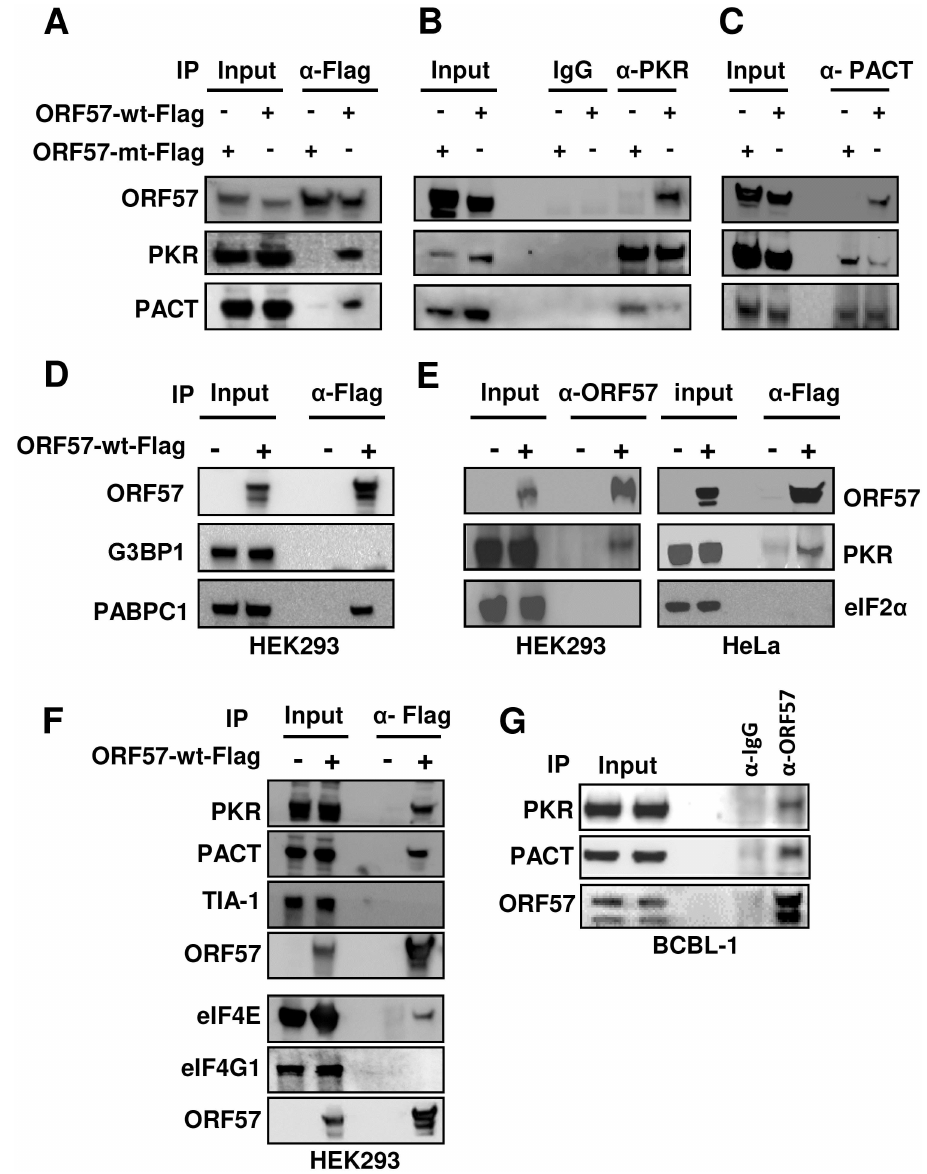
Fig 5. ORF57 interacts with PKR, PACT and PABPC1, but not G3BP1, eIF2 α and TIA-1. (A-C) ORF57, but not ORF57 mt, interacts with componentsPACT and PKR of SG and inhibitstheir recruitmentactivities in arsenite-treated cells. HEK293cells were transfected with an empty vector (-) or a vector expressingFlag- taggedORF57-wt or ORF57-mt. Total cell lysates at 24 h after transfectionwere digested with RNase A/T1 to excludeany possibilityof RNA-mediatedprotein-protein interactions in subsequent co-immunoprecipitation. (A) The ORF57-associatedproteins were co-immunoprecipitated by a mouse anti-Flag antibody for ORF57 and the proteins in the pulldownwere blotted with each correspondingantibody for endogenousPKR and PACT in additionto ORF57. (B-C) ORF57 interactionwith PACT and PKR inhibitsarsenite-induced PACT-PKR interactions. RNase-treated cell extracts in (A) were immunoprecipitatedby an anti-PKR(B) or anti-PACT (C) antibody,and blotted for PKR-associated ORF57 and PACT (B) or PACT-associated ORF57 and PKR (C). Anti-Flag antibodywas used to blot wt and mt ORF57. (D-F) Interaction of ORF57 with PABPC1, PKR, PACT and eIF4E, but not with G3BP1, eIF2 α , TIA-1 and eIF4G1. The cell extract derived from HEK293 or HeLa cells with transfectionof an empty vector or an ORF57-wt-Flag expressionvector were treated with RNase A/T1 and then co-immunoprecipitated by a mouse anti-Flag for ORF57 (D-F) or a polyclonal rabbit anti-ORF57 (E, left panel)for ORF57-associatedG3BP1 and PABPC1 (D), PKR and eIF2 α (E), and PKR, PACT, TIA-1, eIF4E and eIF4G1 (F). Approximate 30% proteins pulleddown from the co-IP were blotted with the corresponding antibody for G3BP1, PABPC1, PKR, eIF2 α , PACT, TIA-1, eIF4E,